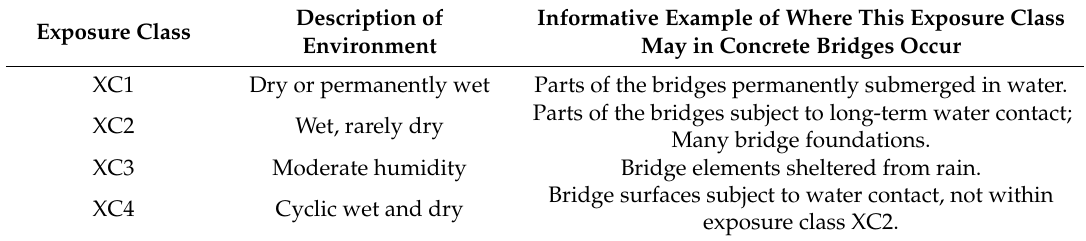
Table 1. Description of exposure classes for the corrosion induced by carbonation according to EN 206-1 [38], with informative examples given for